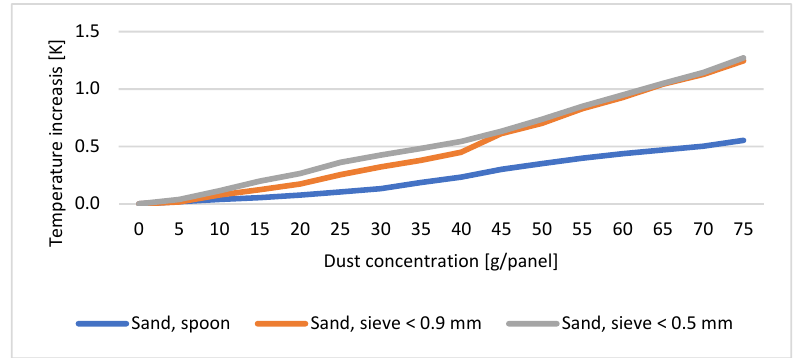
Figure 13. The temperature increase as a function of the soil concentration.